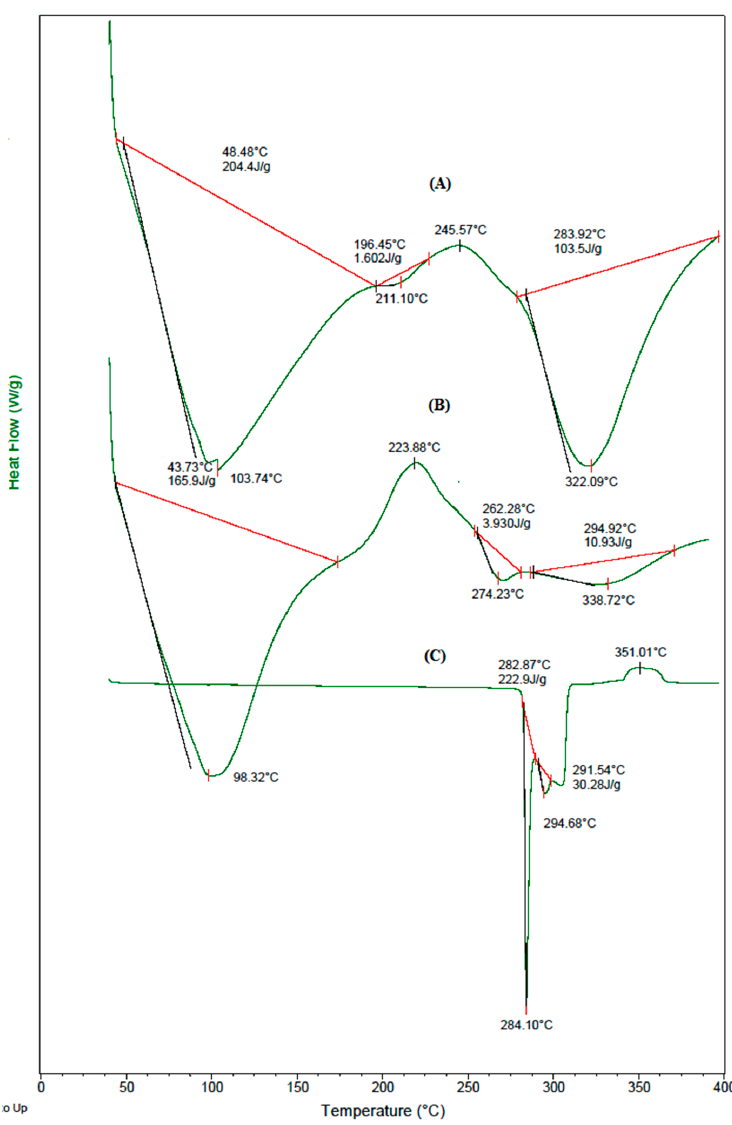
Figure 4. DSC thermograms of ( A ) placebo blend hydrogel microspheres; ( B ) 5-FU-loaded blend hydrogel microspheres and ( C ) 5-FU.